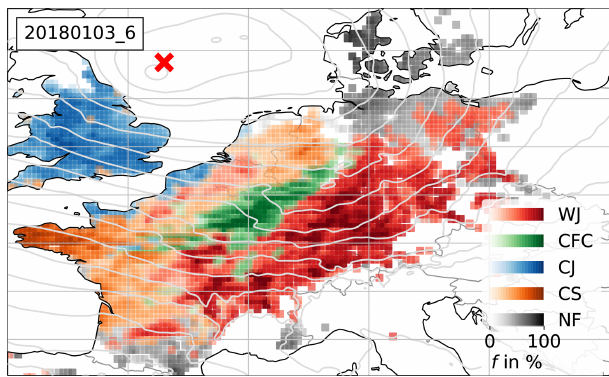
Figure 5. RF-derived probabilities f for each feature for Burglind on 3 January 2018 at 06:00UTC, as in Fig. 4b but for COSMO-